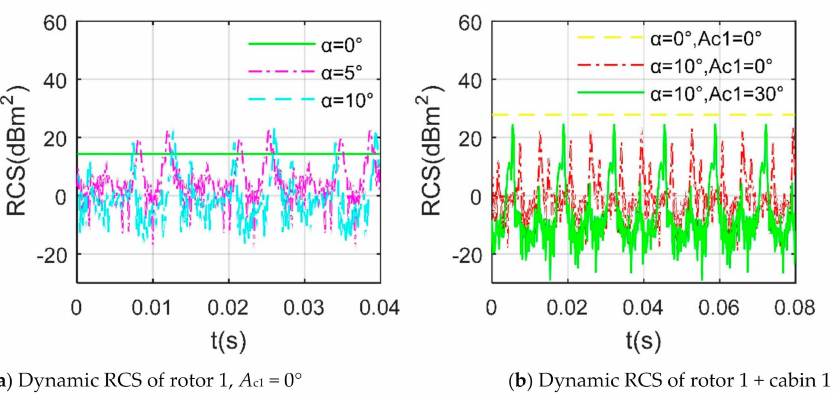
Figure 8. Dynamic RCS of different components, f rh = 10 GHz, n r1 = 1500 r/min. ( a ) Dynamic RCS of rotor 1, A c1 = 0 ◦ . ( b ) Dynamic RCS of rotor 1 + cabin